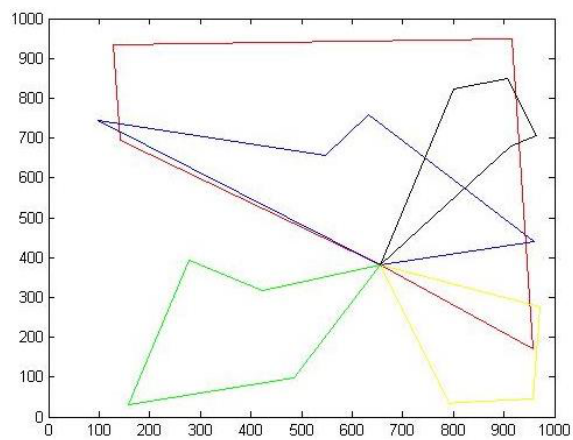
Figure 7. Scenario IV, Average answer is 6714.16 m, average time is 279.25 s.